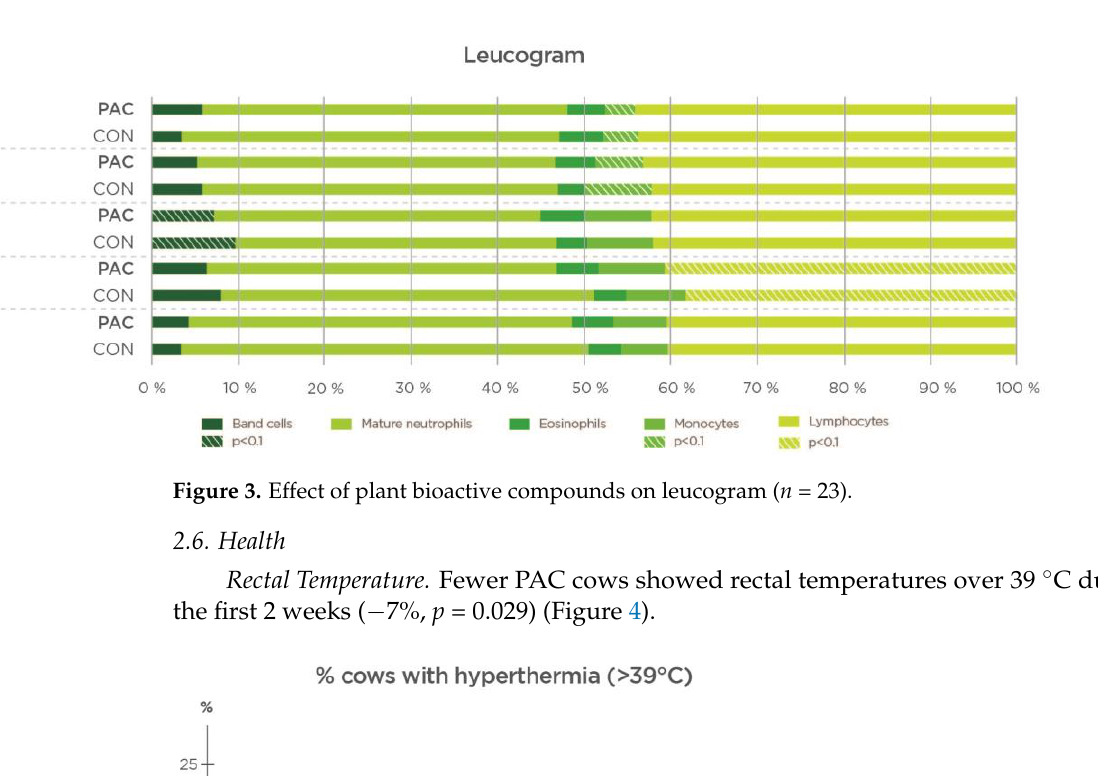
Figure 2. Effect of plant bioactive compounds on total number of white blood cells and granulocytes ( n = 23).